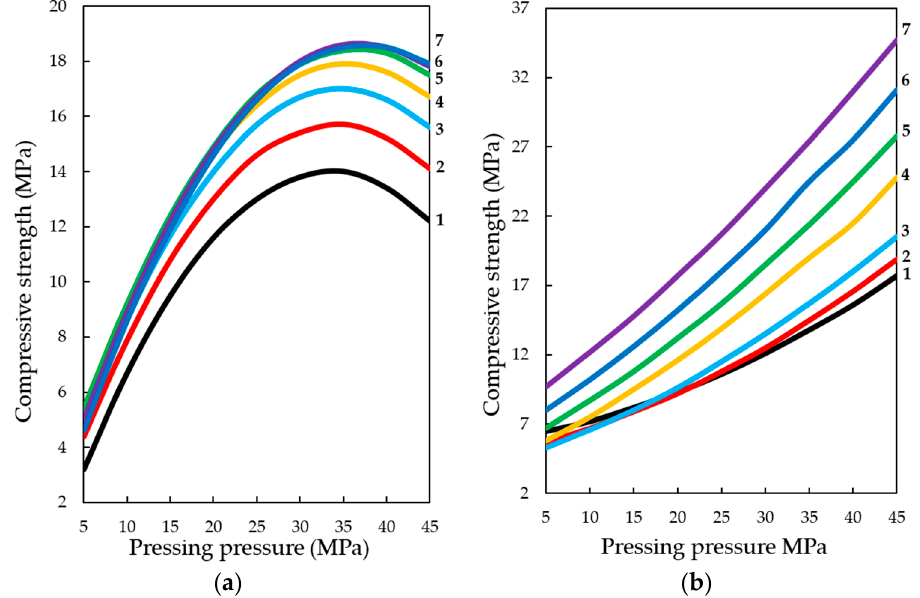
Figure 14. Change in compressive strength of testing samples made from a raw mix containing 22% wt. of lime dust (equivalent to Ca(OH) 2 —10% wt.) carbonated by: ( a ) dynamic and ( b ) static methods, during 5 cycles / 900 s, depending on the forming pressure of pressing and concentration of СО 2 , %: 1 —10; 2 —20; 3 —30; 4 —40; 5 —50; 6 —60; 7